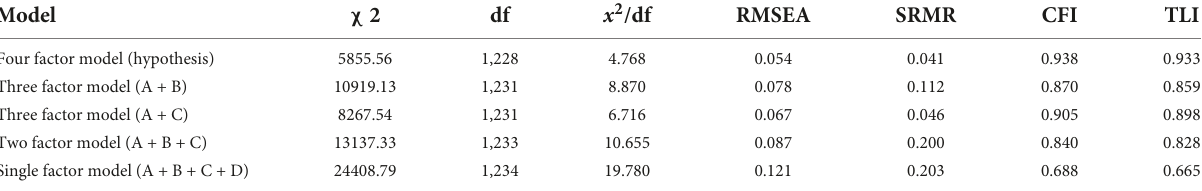
TABLE 1 Confirmatory factor analysis results ( N = 1279).